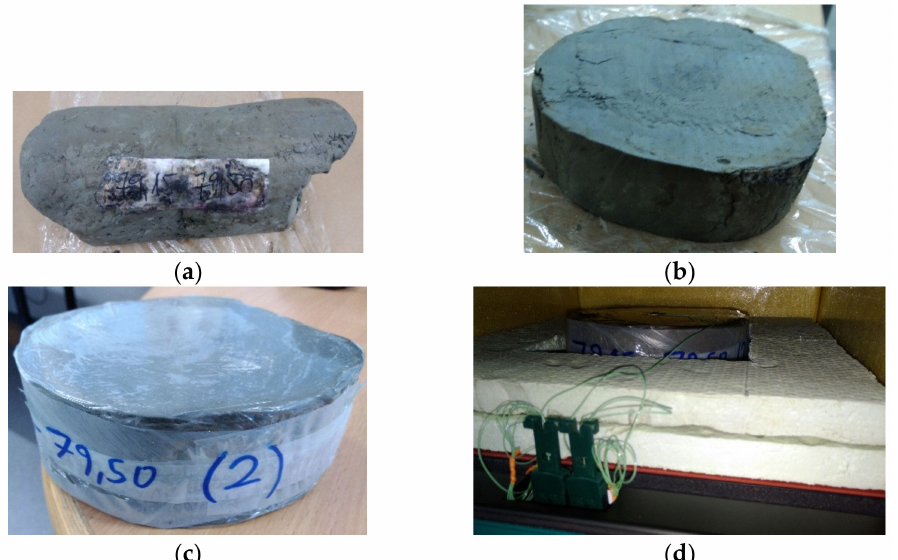
Figure 5. ( a ) Drill core from the depth 79.15 to 79.5 m; ( b ) prepared cylindric sample with a diameter of Ø~158.25 (2.39) mm and a thickness of d = 56.22 (0.105) mm; ( c ) sample packaged in polyethylene foil; ( d ) sample setup in the HFM with thermocouples connected to the top and bottom faces of the sample, surrounded by a polystyrene